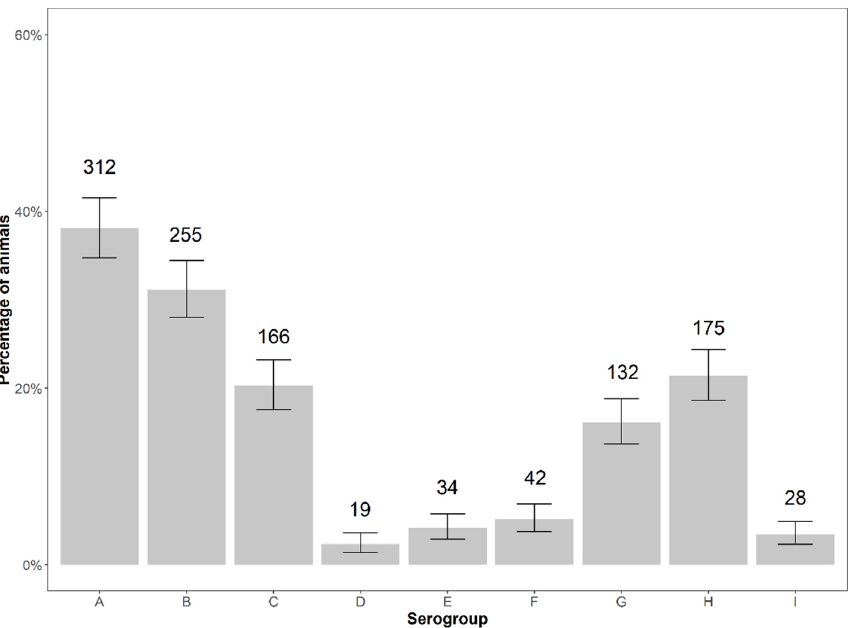
Figure 3. Number and percentage (referring to 819) of animals positive for serogroups A–I of D. nodosus with exact binomial 95% confidence intervals.